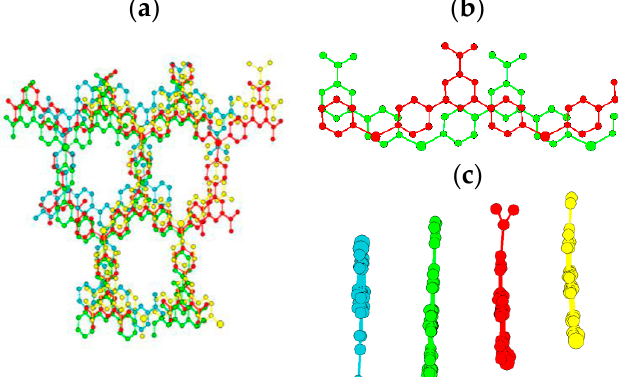
Figure 2. Four-layer interpenetration arrangement of Cu(tpt)(BF 4 ) · 3 species omitted for clarity.